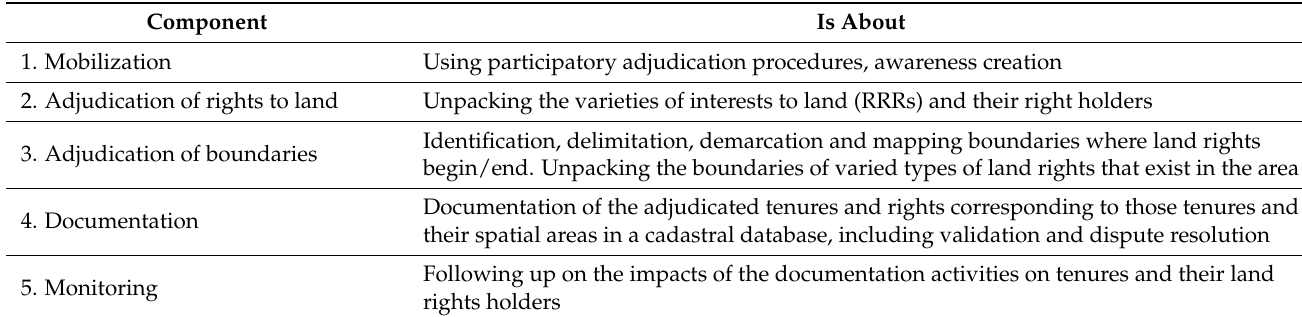
Table 1. Essential components of a community-based adjudication process.